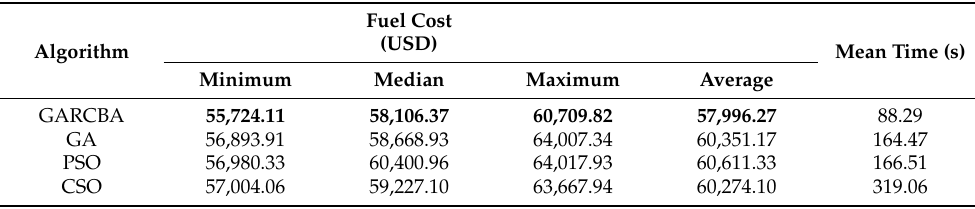
Table 8. Statistical results for Case 2 from 25